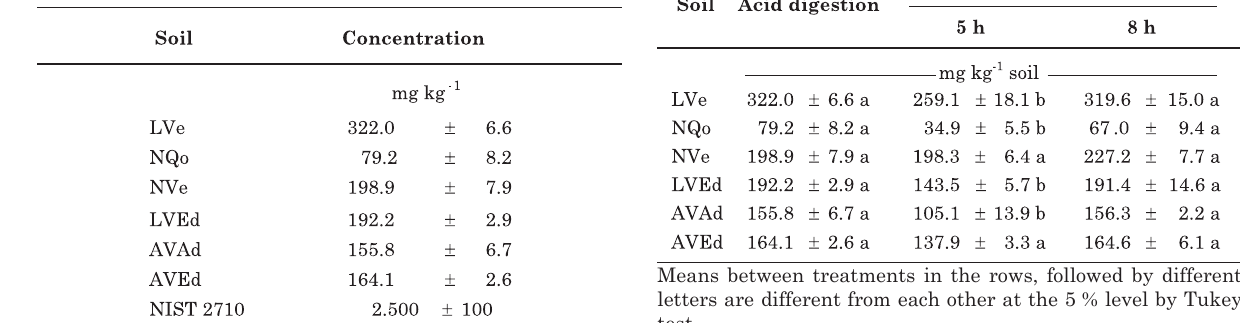
Table 4. Total S and alkaline oxidation yield with a mixture containing NaHCO